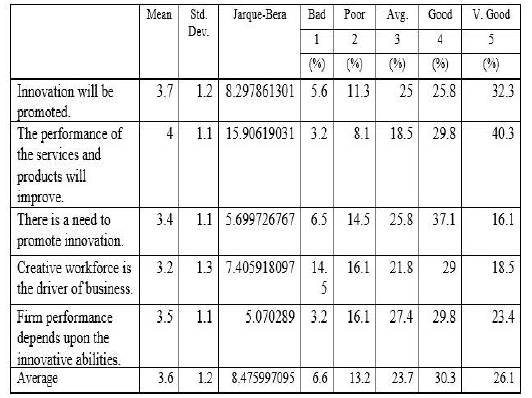
Table 2: Meso-Economic